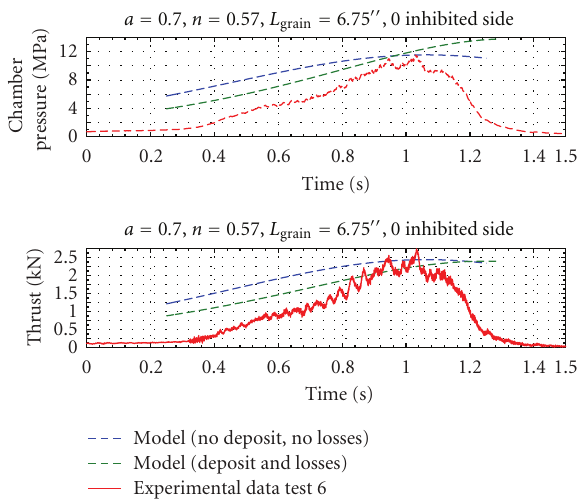
Figure 9: Comparison of 7 (cid:4)(cid:4) long ALICE motor tests with lumped parameter